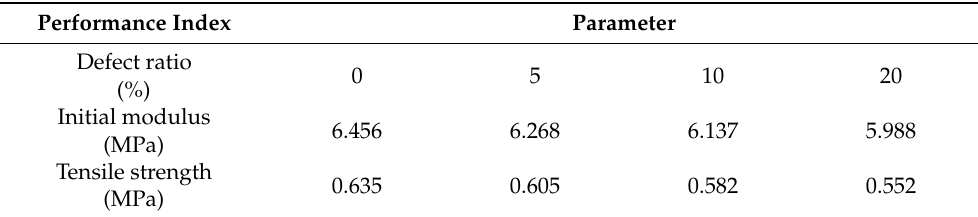
Figure 9. Uniaxial tensile results of HTPB propellant with initial interface defects.